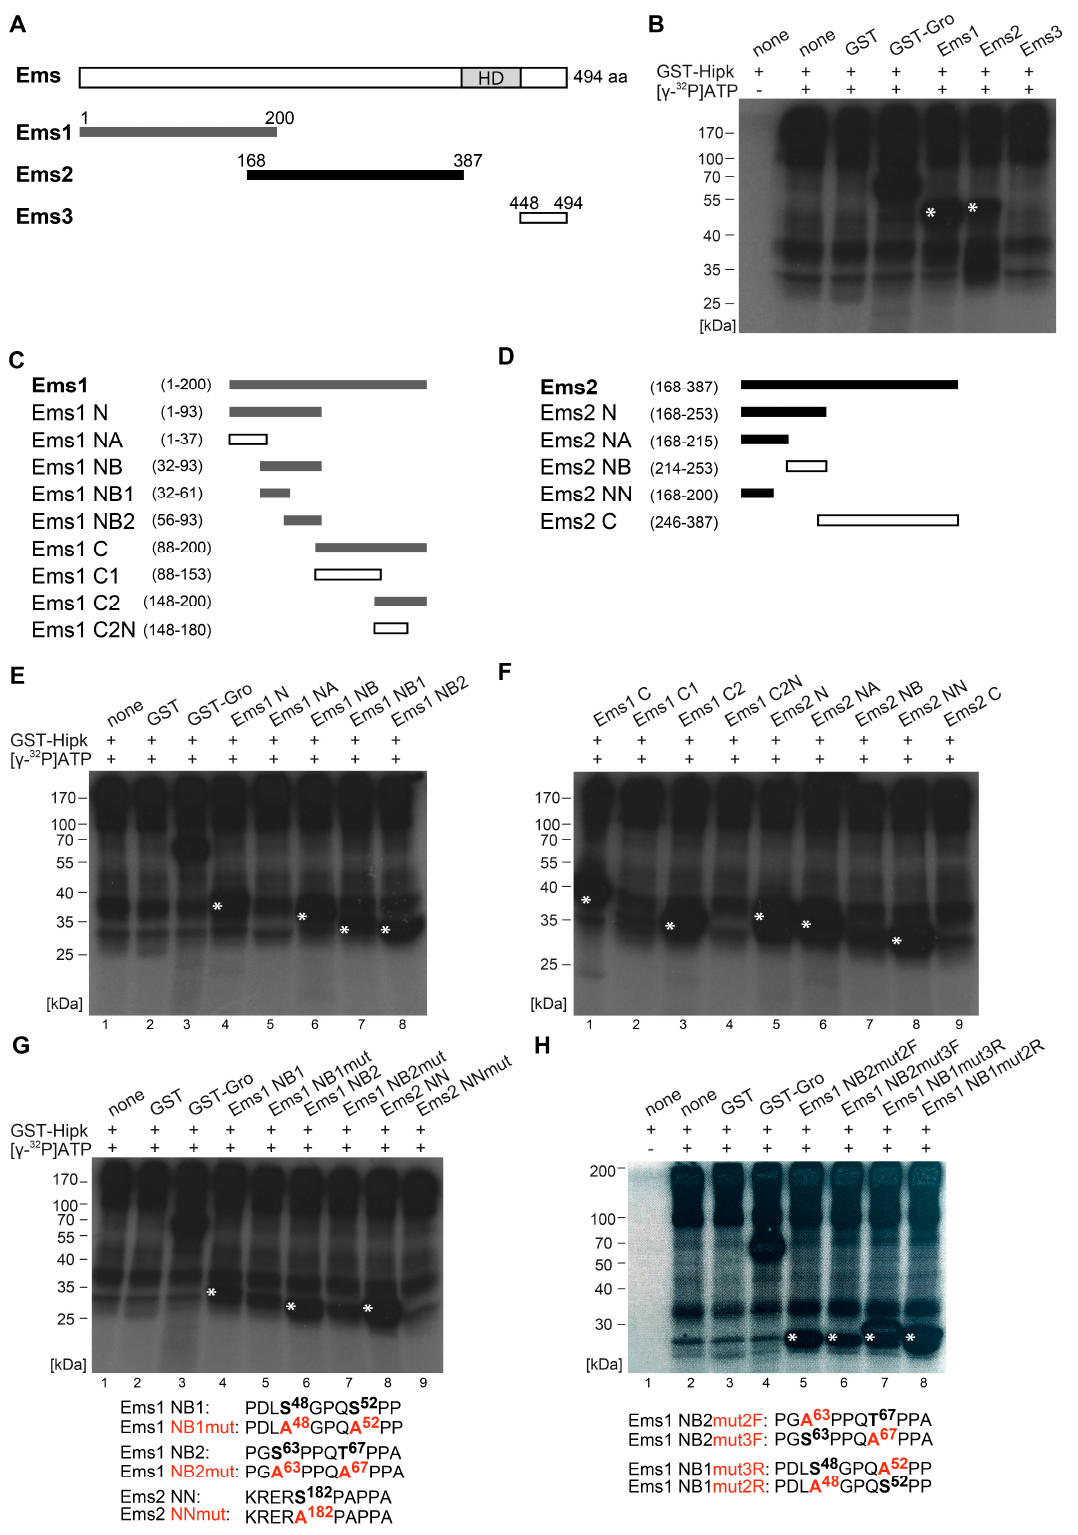
Figure 3. Hipk phosphorylates Empty spiracles (Ems). ( A ) Schematic view of the full-length protein Empty spiracles (Ems) with 494 amino acids (aa), Homeodomain (HD), and the corresponding amino terminal Ems1, Ems2, and carboxy terminal Ems3 constructs that were purified and analyzed by phosphorylation assay. Numbers indicate terminal amino acid positions of the constructs. Phosphorylated constructs are represented in dark grey / black and not phosphorylated constructs are